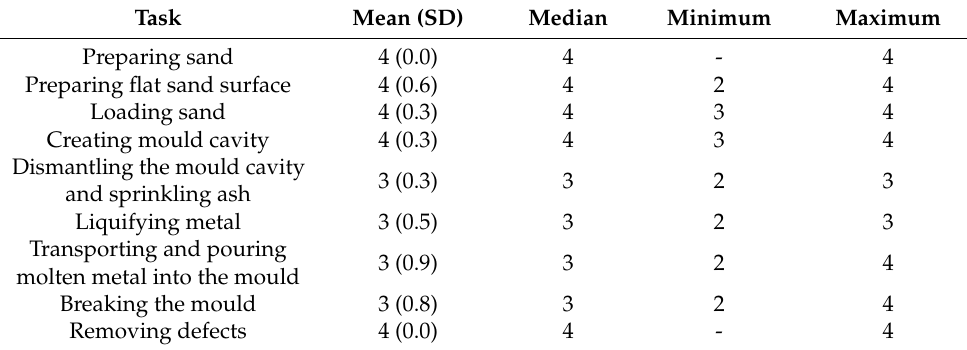
Table 3. RULA action levels for each task.